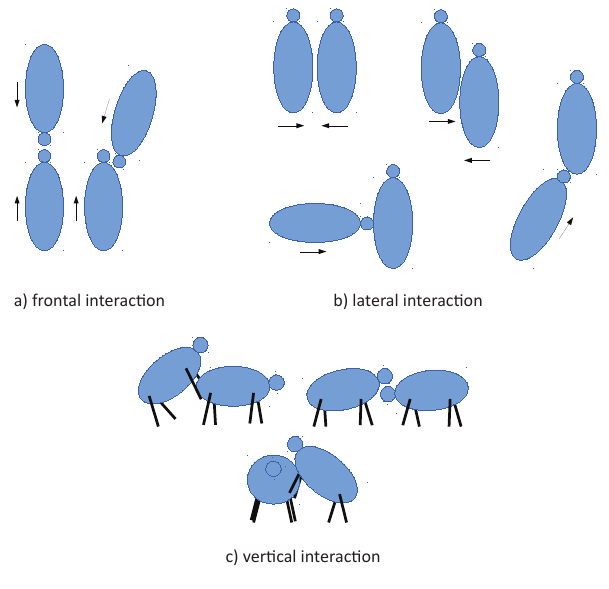
Fig. 2. Schematic examples of interaction classes: (a) frontal, (b) lateral, and (c)